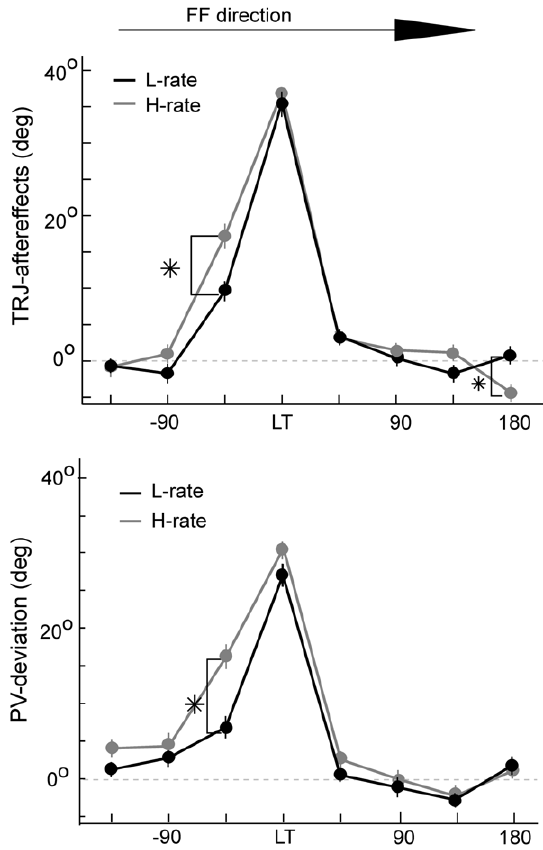
Figure 7. Generalization of local force-field learning is asymmetrical around the learned target (LT) and dependent on the practice schedule. The effect is measured by the initial directional deviations of the trajectories (TRJ-aftereffects, upper plot) and the corresponding population vectors (PV-deviations, lower plot). The figure shows the TRJ-aftereffects (upper) and PV-deviations (lower) from targets around LT during L-rate (black) and H-rate (grey) learning, taken at late stages of adaptation. Deviations from target at -45 u were almost 10 u larger under H-rate than L-rate (p , 0.01). Note that for illustration purposes, positive values were assigned to deviations counter to the force field direction. In addition, measuring TRJ- aftereffects to the LT was only possible in STD2 after the first epoch of learning trials. Number of cells =298 for late days of L-rate, number of cells =156 for H-rate. Error bars denote SEM. Asterisks denote 1%